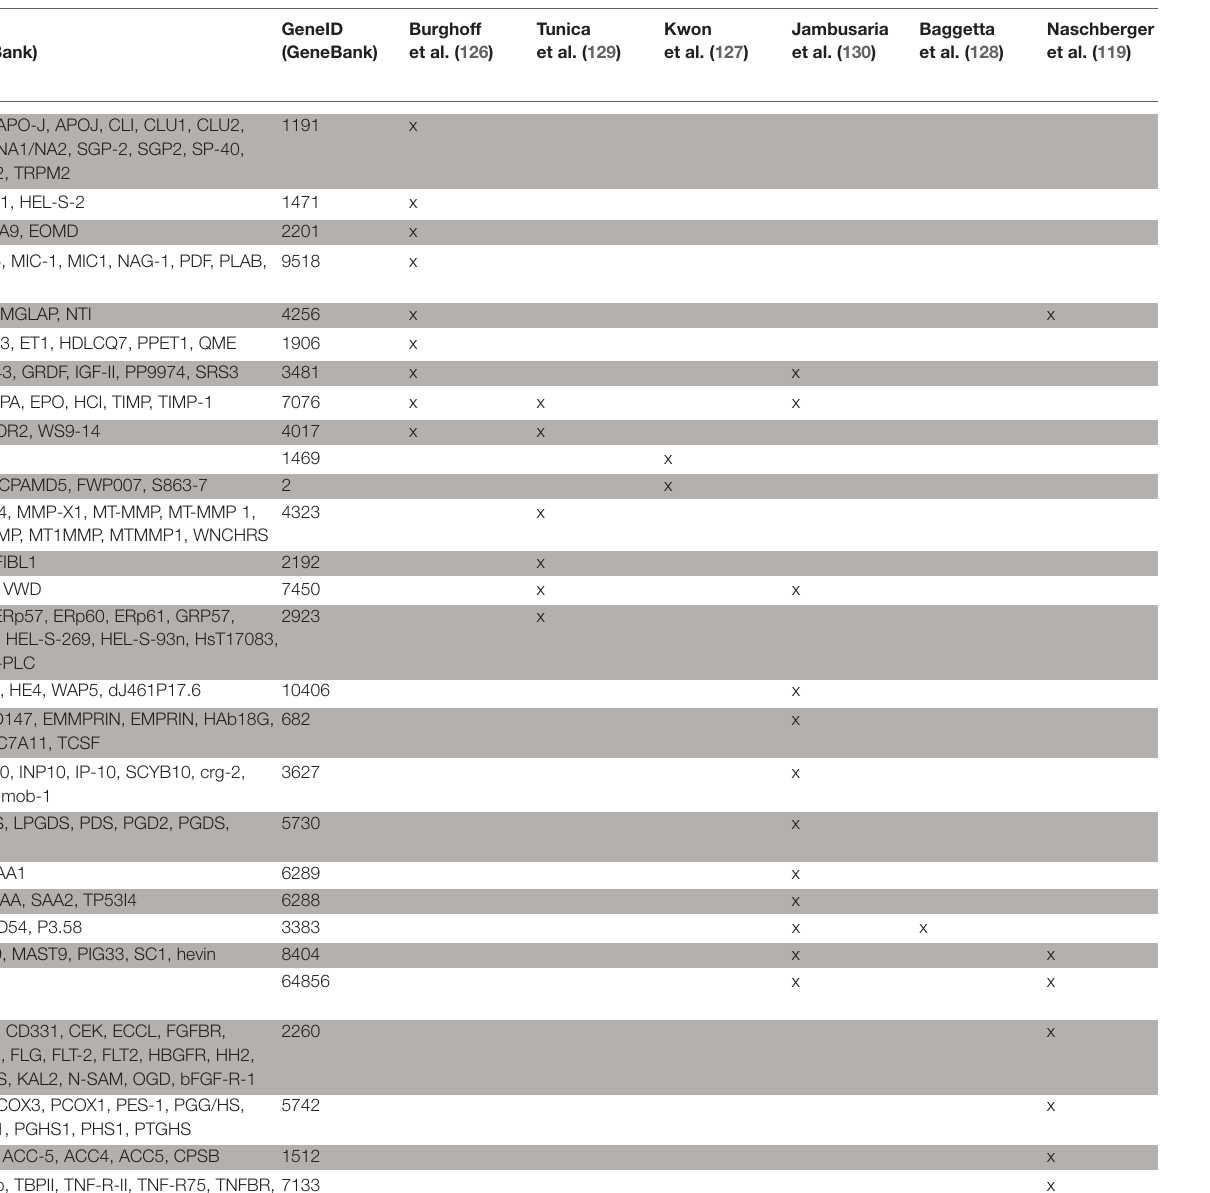
TABLE 1 | Angiocrine barrier-modulating candidate genes in inflammatory bowel